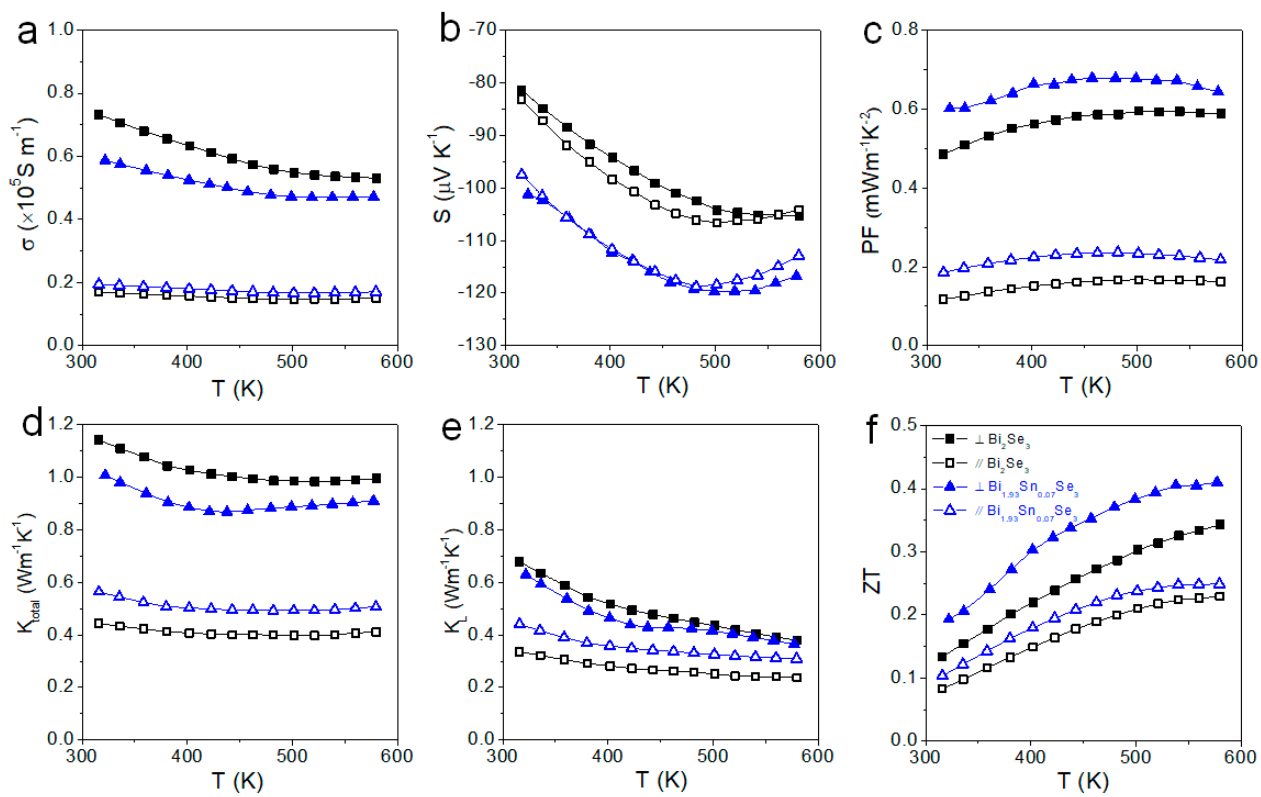
Figure 9. TE properties of Bi 2 Se 3 and Bi 1.93 Sn 0.07 Se 3 parallel (//) and vertical ( ⊥ ) to the pressure axis: ( a ) electrical conductivity, σ ; ( b ) Seebeck coefficient, S ; ( c ) power factor, PF ; ( d ) total thermal conductivity, κ ; ( e ) lattice thermal conductivity, κ L ; and ( f ) the TE figure of merit, ZT .